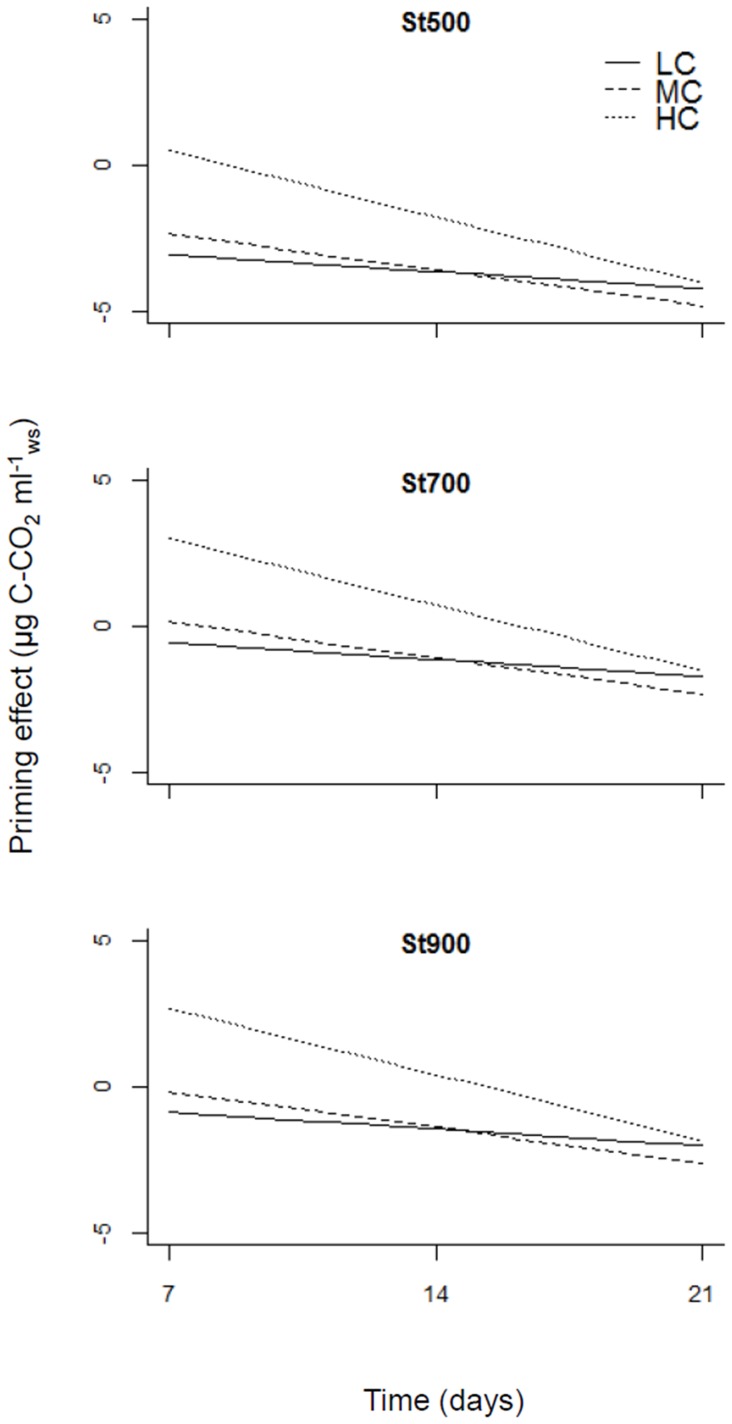
Temporal trends in priming effect (µg C-CO2 ml−1
ws) with increasing levels of substrate quantity.LC, MC and HC stand for low, medium and high diatom quantity treatment respectively.